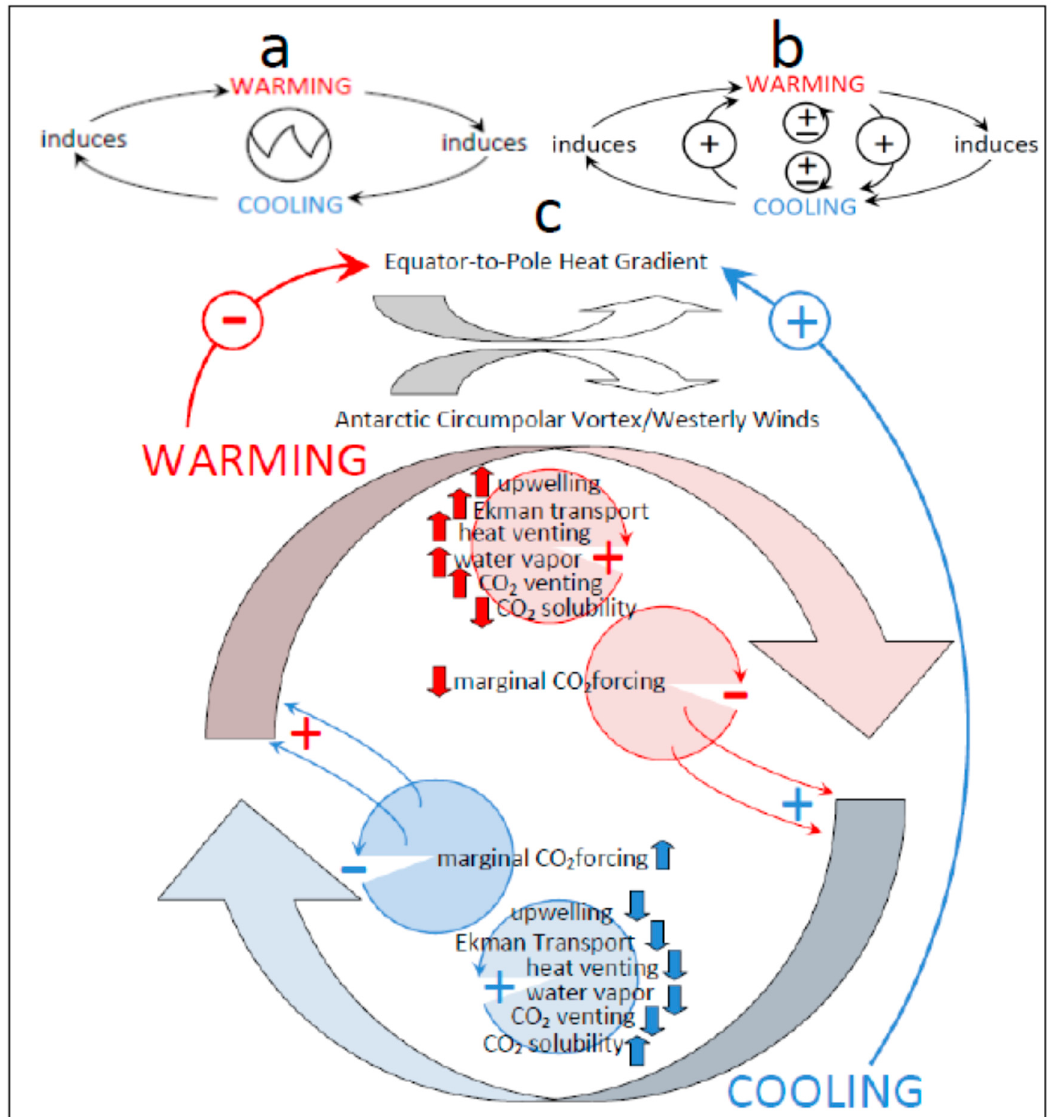
Figure 15. The relaxation-oscillation (RO) hypothesis of the Antarctic Centennial Oscillation (ACO) and its modern counterpart, the Antarctic Oscillation (AAO). ( a ) Schematic diagram of the ACO / AAO relaxation oscillator in its simplest form. ( b ) Schematic inclusion of the positive and negative feedbacks that trigger and reinforce each phase of the ACO / AAO temperature cycle. ( c ) Schematic summary of the RO model showing some but not all of the most significant internal and external feedbacks supporting the ACO / AAO temperature cycle. Plus and minus signs signify positive and negative feedback, respectively. This schematic diagram is a formalization of the RO model documented previously [13] and explains the ACO / AAO temperature cycle, and therefore global climate on centennial scales, in terms of relaxation oscillation of Westerly Winds (WWs) in the Southern Hemisphere